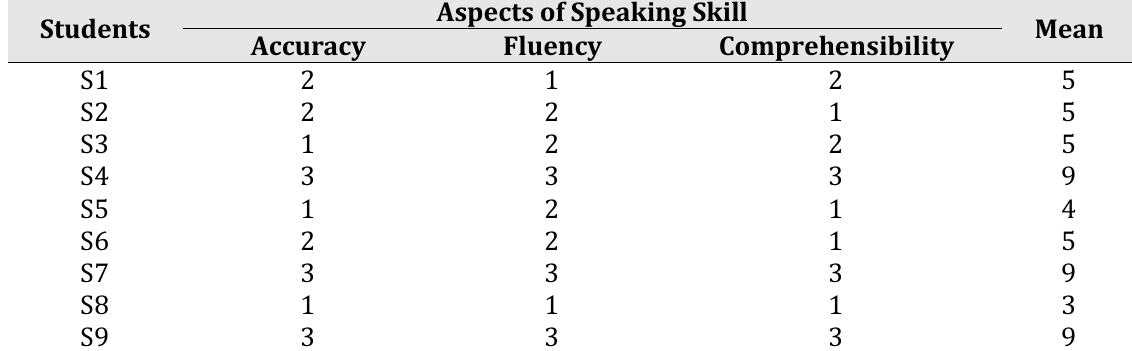
Table 5. Point of Students’ Pre -test